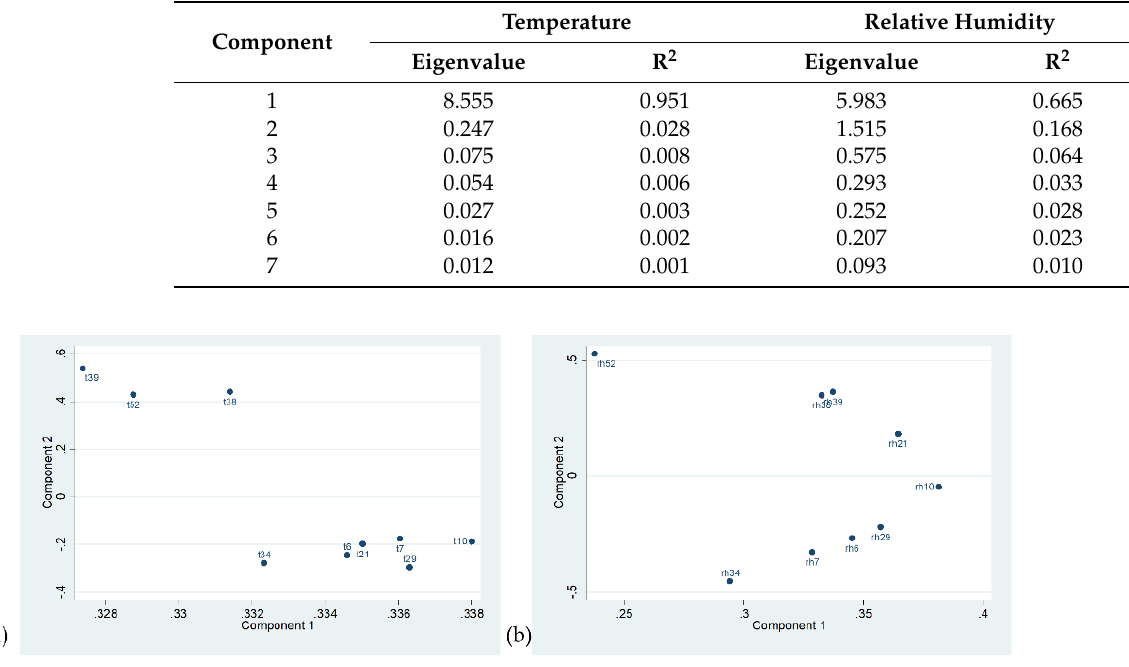
Figure 7. Scatter plot of the loadings corresponding to Component 2 versus Component 1 for the hourly data of ( a ) temperature and ( b ) relative humidity. Table 4. Summary of PCA outcomes obtained from hourly observations of temperature and RH (R2 is the proportion of variability explained by each component).